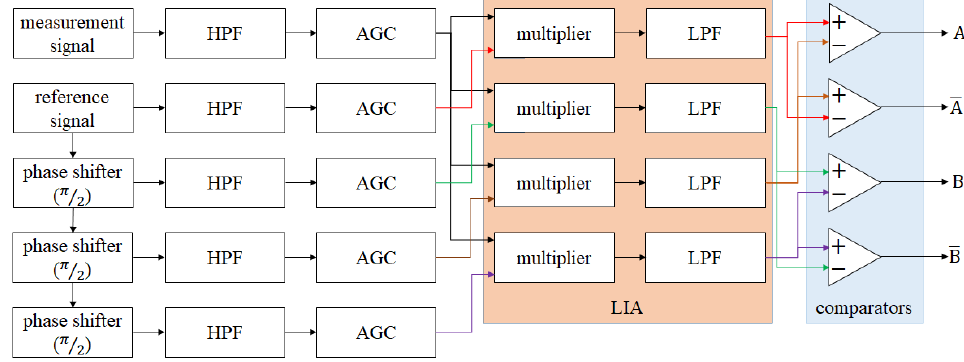
Figure 10. Block diagram of the experimental LIA circuit.